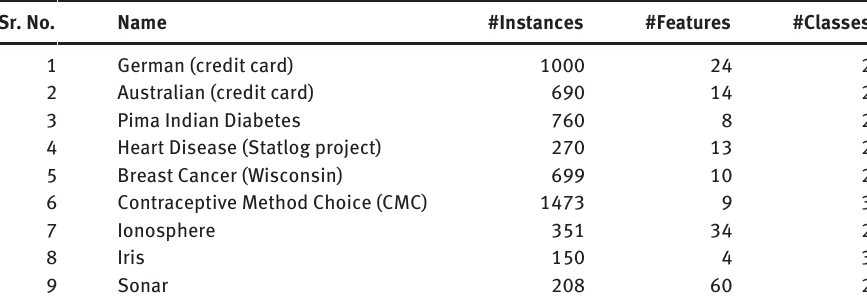
Table 1. Data Set